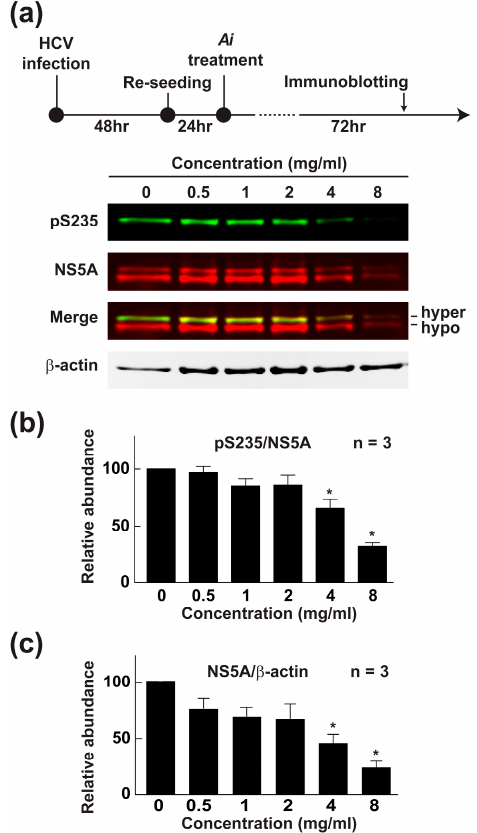
Figure 5. Aeginetia indica decoction reduced HCV NS5A phosphorylation at serine 235. Representative ( a ) and summary of immunoblotting for total NS5A ( b ) and S235 phosphorylated NS5A ( c ) in HCV-infected Huh7.5.1 cells treated with vehicle or Aeginetia indica decoction. Values are mean ± SEM summarized from three independent experiments and normalized against values under the vehicle control (0 mg/mL). β -actin serves as a loading control. Asterisk indicates p < 0.05, t -test against the values under the vehicle control. Ai, Aeginetia indica decoction; hyper, hyper-phosphorylation; hypo, hypo-phosphorylation.